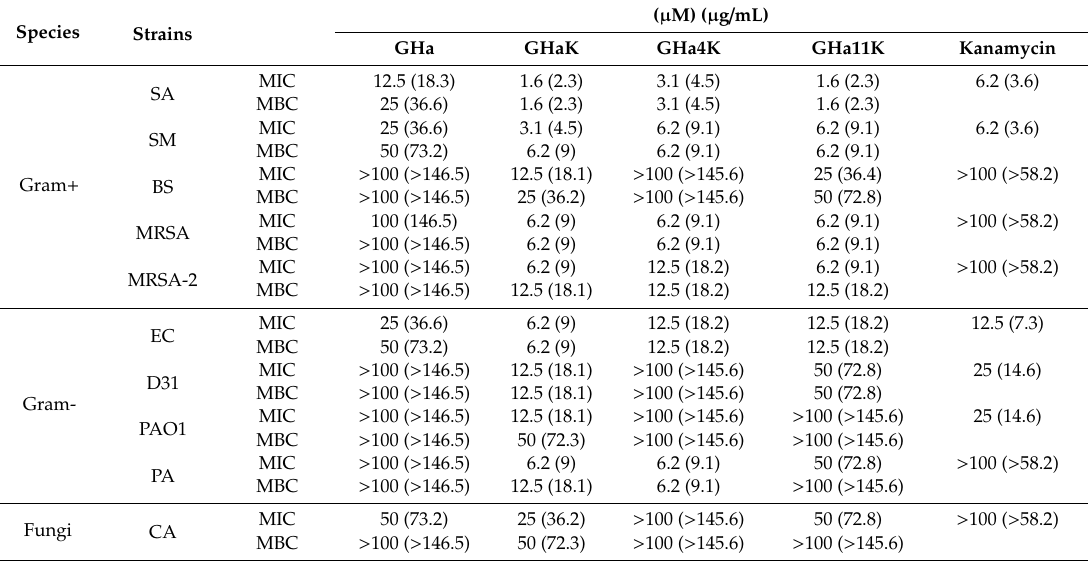
Table 2. MICs and MBCs of GHa and its analogs against the tested